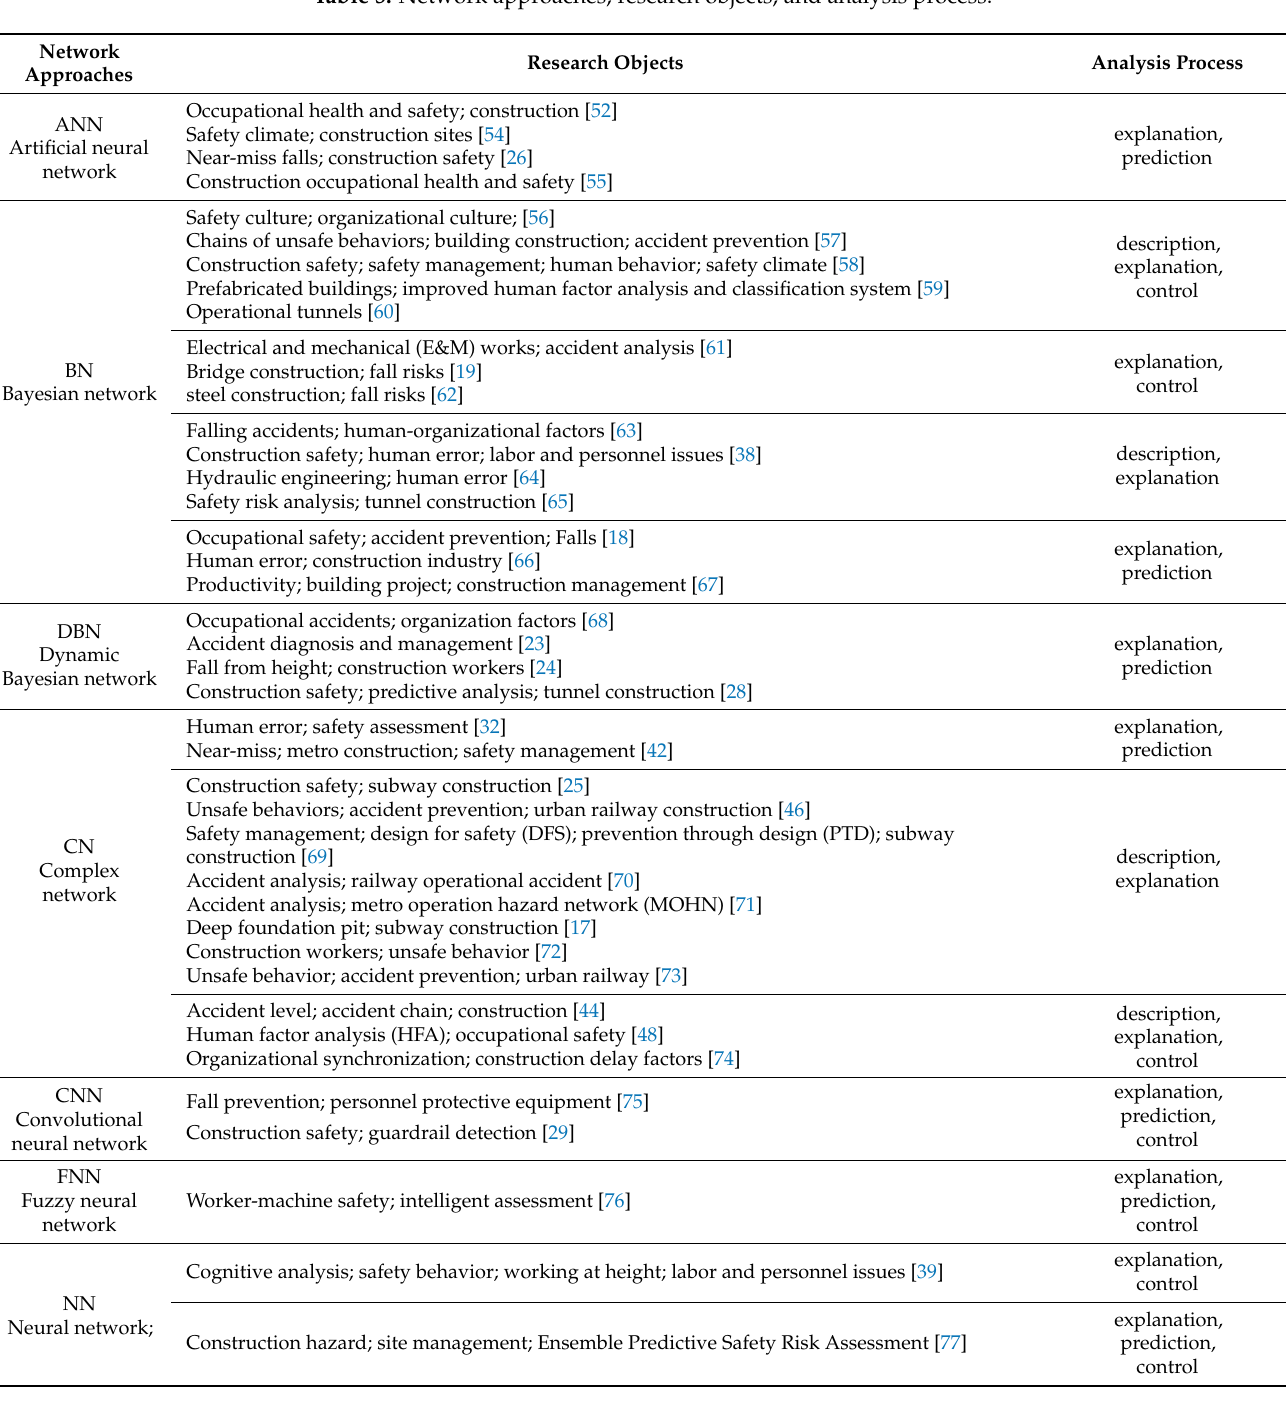
Table 5. Network approaches, research objects, and analysis